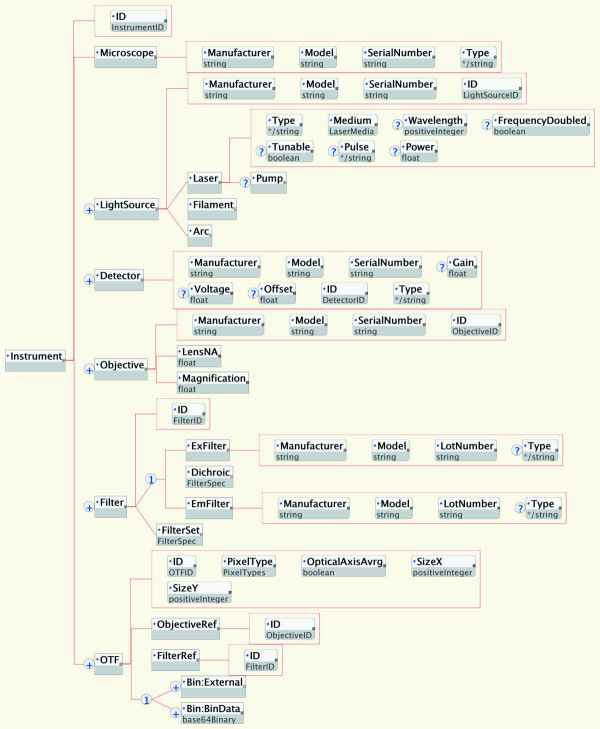
The Instrument element in the OME file schema. The data elements that define the acquisition system parameters are shown. For these descriptions, we have incorporated suggestions from many colleagues and commercial partners [32]. Symbols are as in Figure 2.